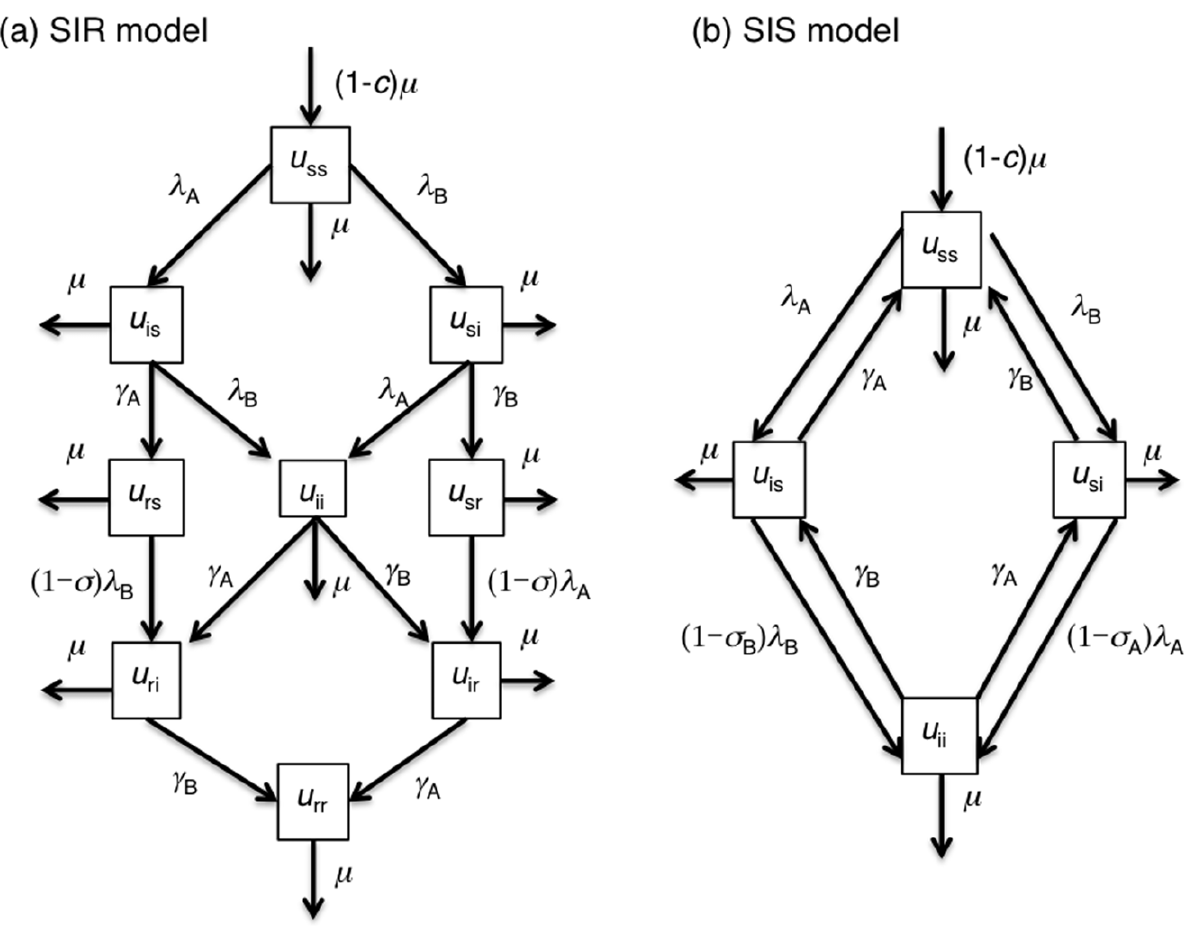
Figure 1. Transmission dynamics of two-strain disease in the presence of cross-protective immunity. (a) Model without re-infection with an identical antigenic type (SIR-type; susceptible-infectious-recovered) and (b) model with re-infections by an identical antigenic type (SIS-type; susceptible-infected-susceptible). SIR model is intended to capture the epidemiological dynamics of EV71, while SIS model is applied to pneumococcus. [Compartments] Variable u represents unvaccinated. Two subscripts represent the state of infection (or carriage) with respect to VT and NVT, respectively. For example, u si represents unvaccinated host who is susceptible to VT but is infected with NVT. [Parameters] c , vaccination coverage; m , background birth and death rates of human host; l A and l B , the rates of infection with VT (vaccine type) and NVT (non-vaccine type), respectively; c A and c B , recovery rates from infection with VT and NVT, respectively; s , the relative reduction of the risk of infection upon exposure by cross-protective immunity in the SIR model; s A and s B , the relative reduction of the risk of carriage acquisition upon exposure to VT and NVT by competition, respectively, in the SIS model. For simplicity, both panels represent the population dynamics of unvaccinated population alone. In case no vaccination takes place, c is equal to 0.